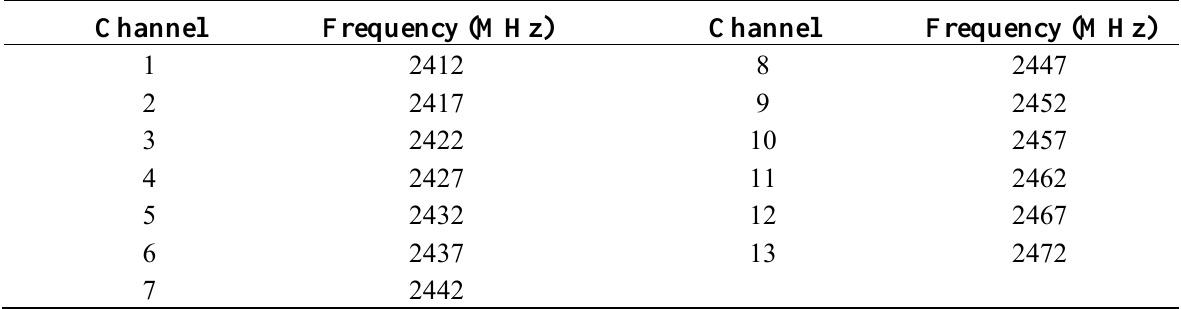
Table 1. Channels inside the ISM band.